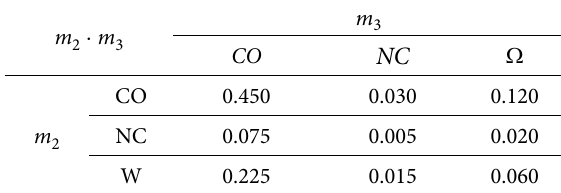
Table 2. BBA Functions having 2